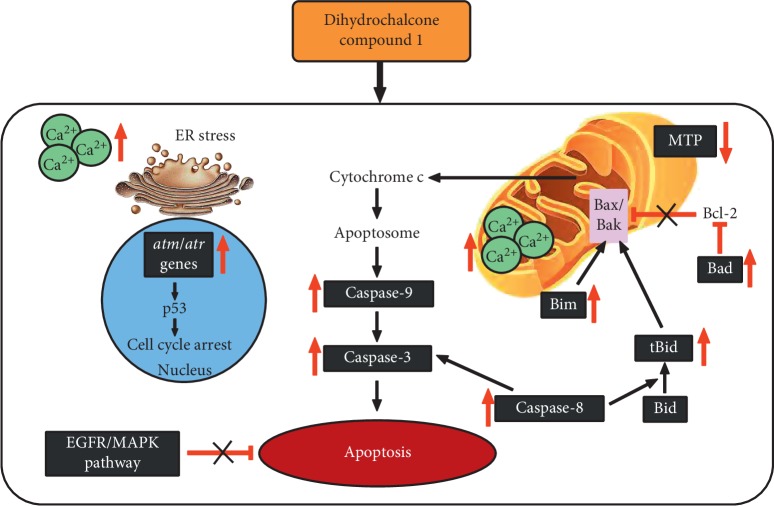
Illustration representing the mechanisms of compound 1-induced human breast cancer cell apoptosis.